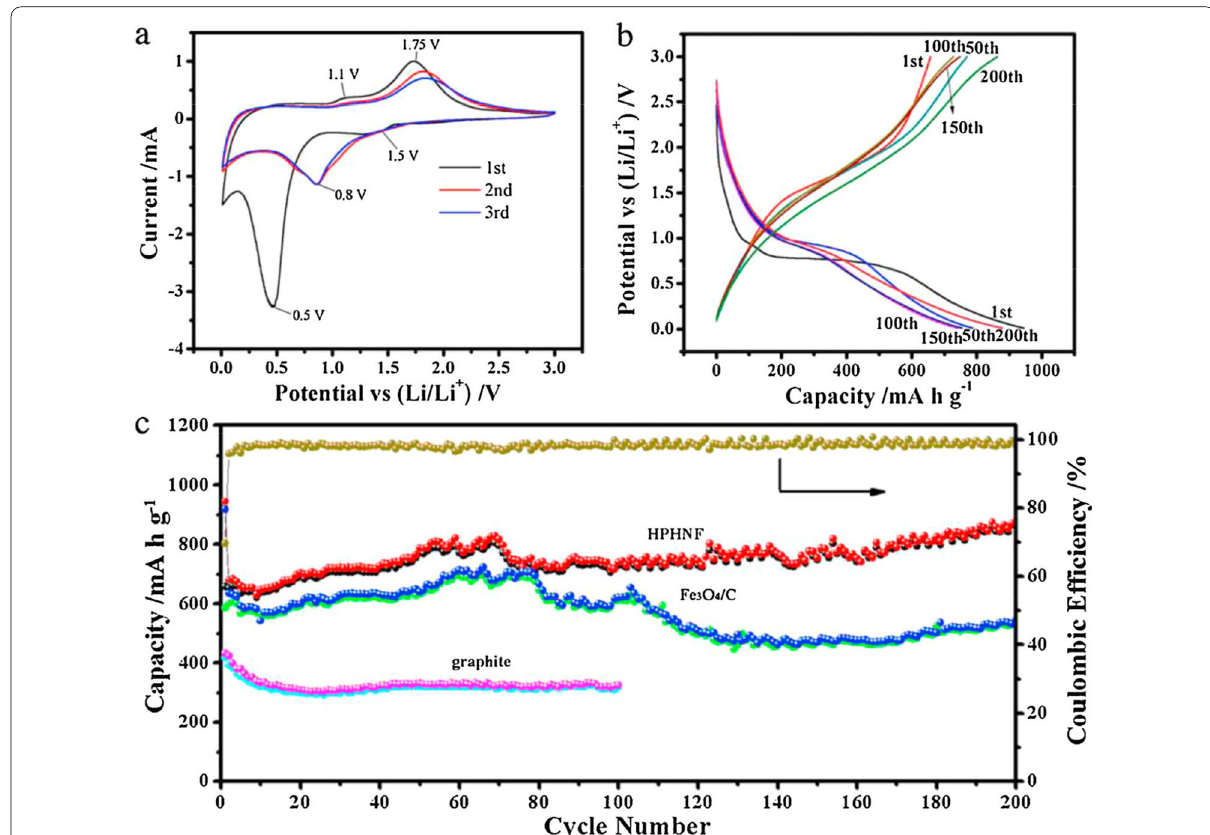
Fig. 12 a CVs of the HPHNF during the first three cycles at 0.2 mV s − 1 , b Galvanostatic charge/discharge profiles of the HPHNF electrodes for the 1st, 50th, 100th, 150th and 200th cycle at a specific current of 200 mA g − 1 . c Cycling performance of the HPHNF nanocomposites, N-doped Fe 3 O 4 /C nanocomposites and graphite at a specific current of 200 mA g − 1 . d Coulombic efficiency of HPHNF. Reprinted with Permission from [12], Copyright, Elsevier